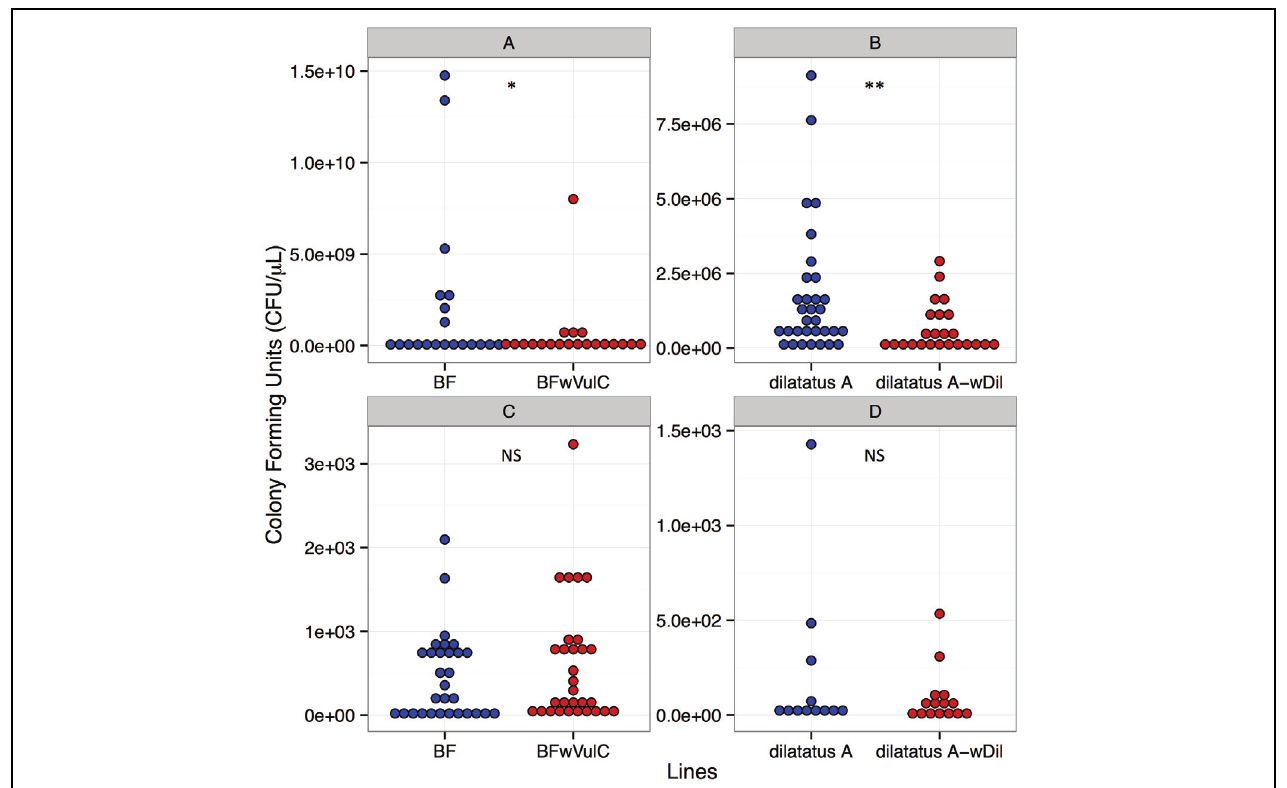
FIGURE 4 | Salmonella typhimurium (A,B) and Listeria ivanovii (C,D) CFUs in A. vulgare and P. dilatatus . CFUs of S. typhimurium from A. vulgare hemolymph (A) , from P. dilatatus hemolymph (B) , CFUs of L. ivanovii from A. vulgare hemolymph (C) and CFUs of L. ivanovii from P. dilatatus hemolymph (D) . ∗ p < 0.05, ∗∗ p < 0.01. NS, not